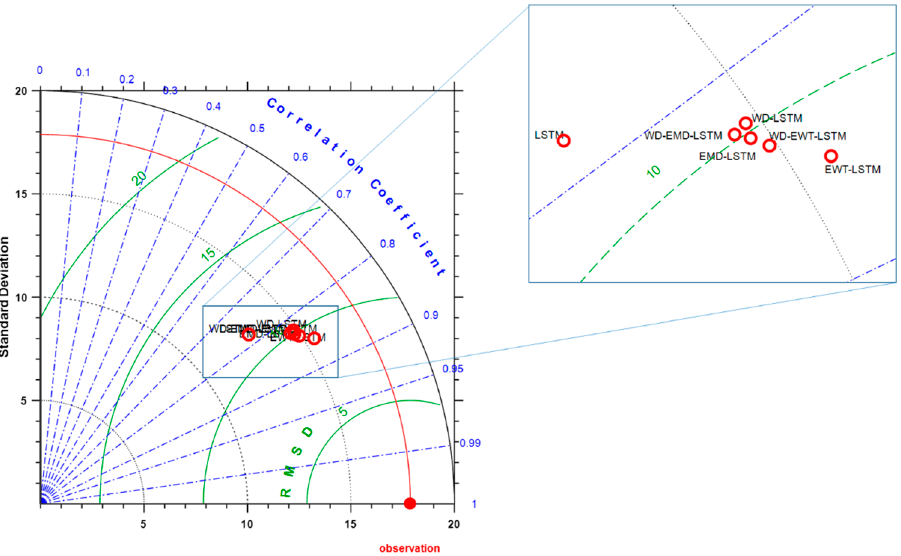
Figure 10. Taylor diagram graphical representation of six predictive models developed for forecasting OCBA TCO time series from 2002 to 2017.